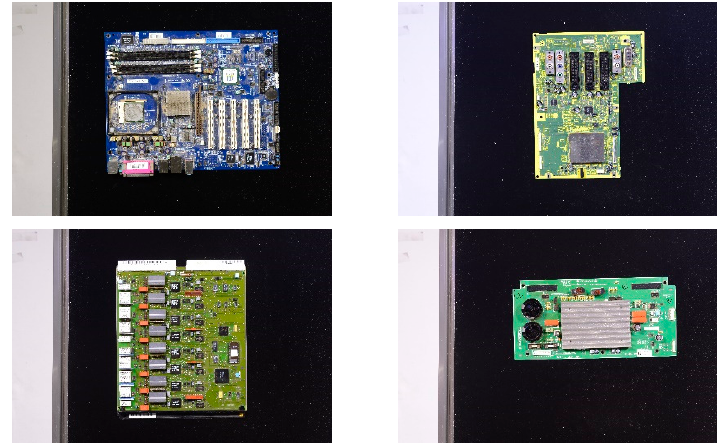
Figure 5. Some instances of the PCB DSLR Dataset. Table 2. Pixel area estimate.